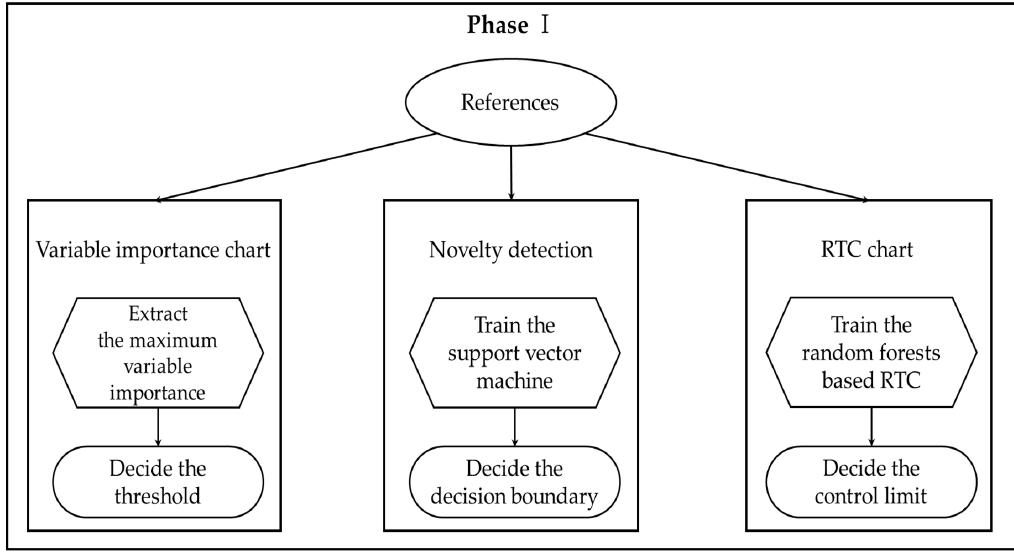
Figure 2. Phase I of the proposed method.